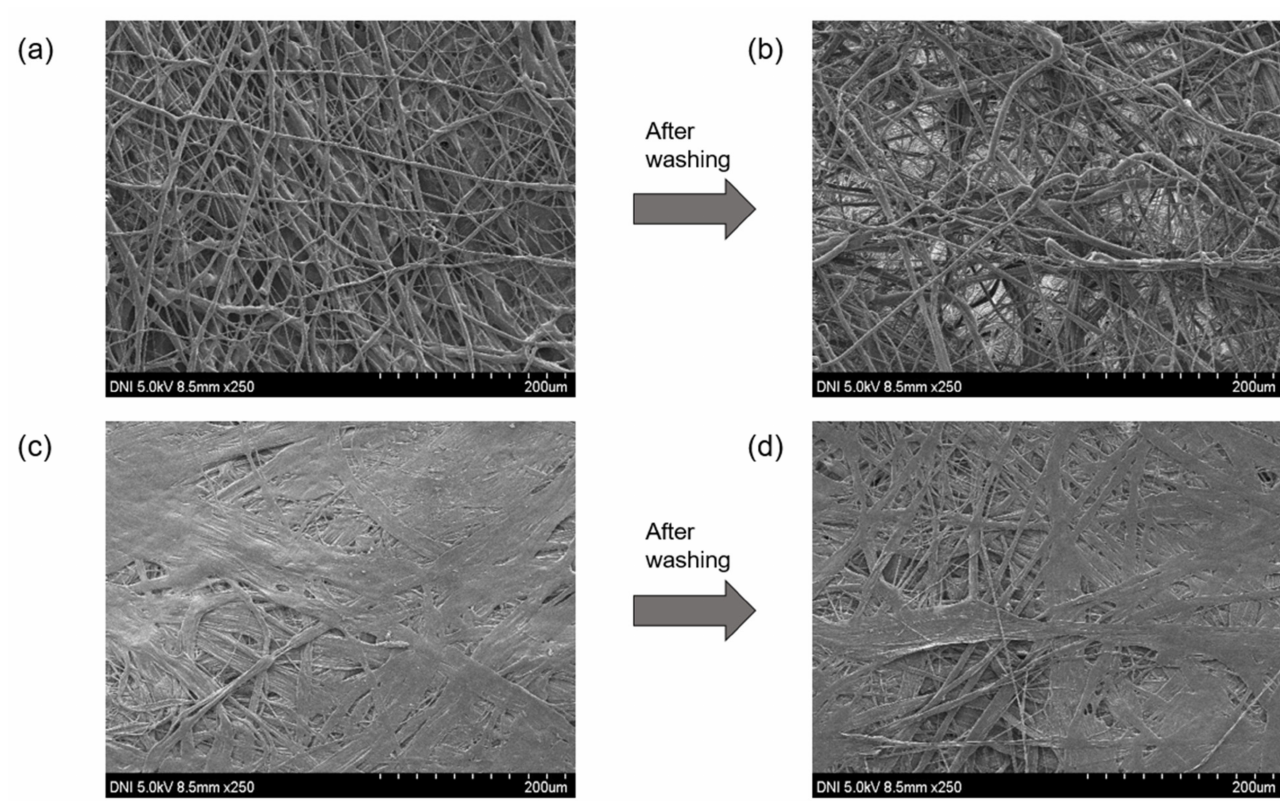
Figure 4. FE-SEM images of the MB nonwoven fabric surface ( a ) before and ( b ) after washing and of the FS nonwoven fabric surface ( c ) before and ( d ) after